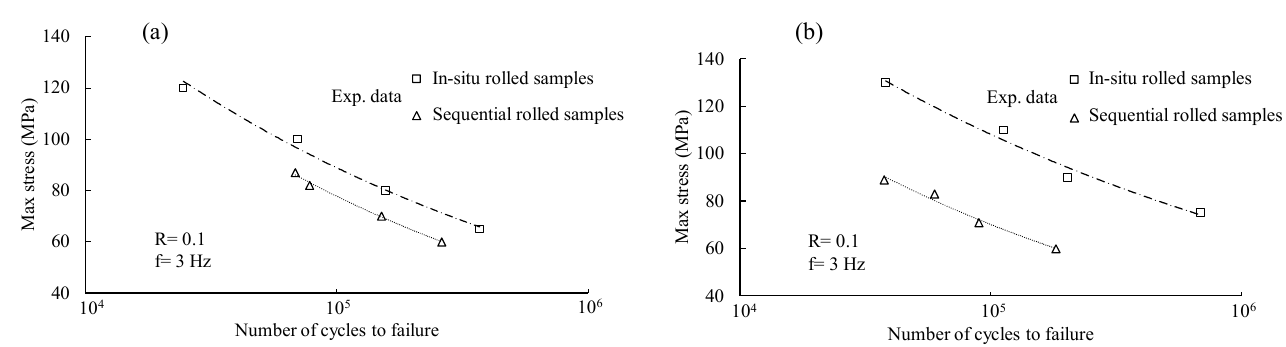
Figure 11. S–N curves of in situ rolled (IR) and sequential rolled (SR) for FSW joints: ( a ) ball size of d = 6 mm; ( b ) ball size of d = 8 mm.